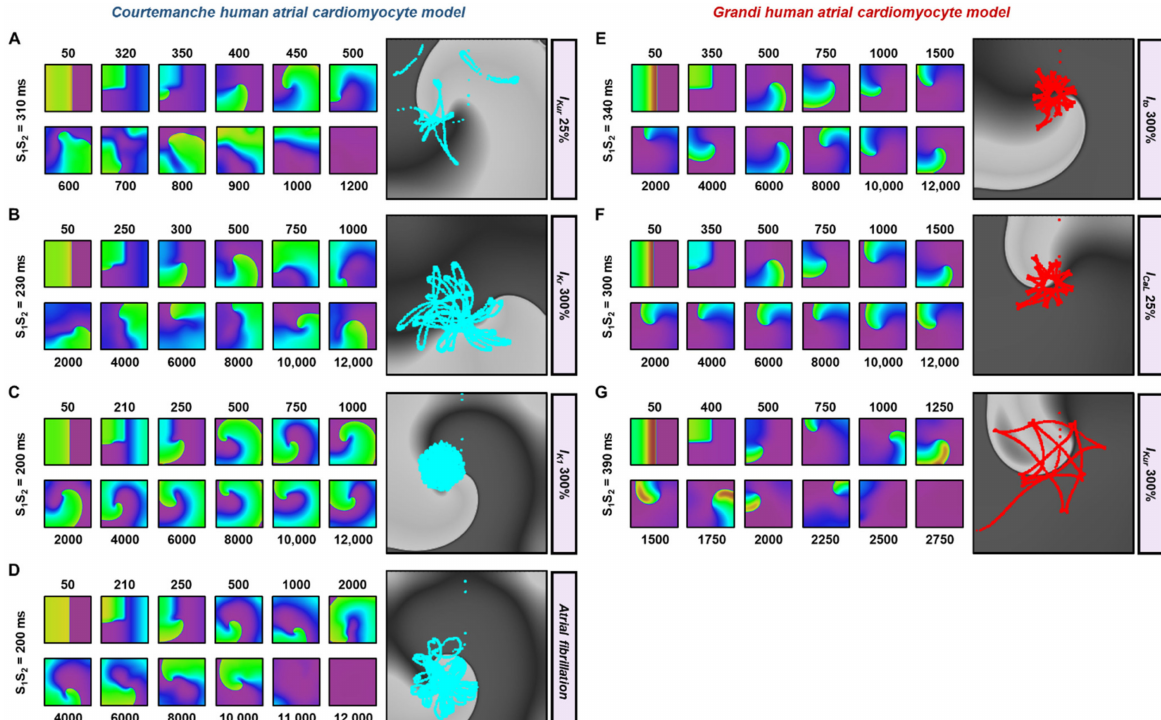
Figure 4. Example snapshots of 2-dimensional tissue simulations showing the effects of ionic current alteration on reentrant waves. ( A – D ) The effects of ionic current perturbations (25% I Kur , 300% I Kr , 300% I K1 and AF electrical remodeling) on reentry in the Courtemanche human atrial cardiomyocyte model. ( E – G ) The effects of ionic current alterations (300% I to , 25% I CaL and 300% I Kur ) on reentry in the Grandi human atrial cardiomyocyte model. The right panels show the rotor-core trajectories tracked up to 3000